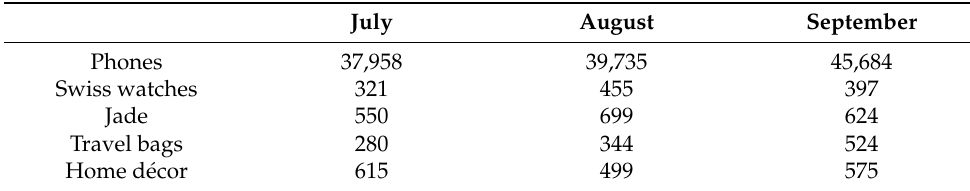
Table 4. Sales of products from July to